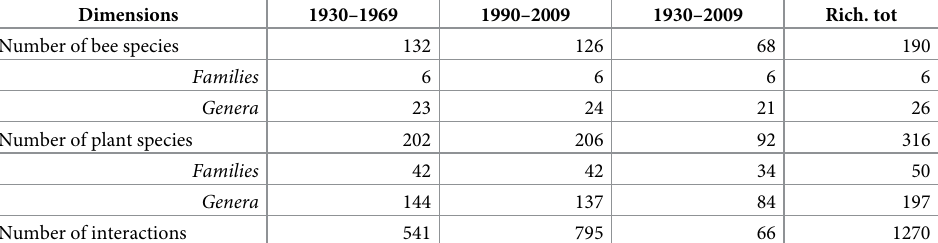
Table 1. Network dimensions according to historical periods (1930–1969 and